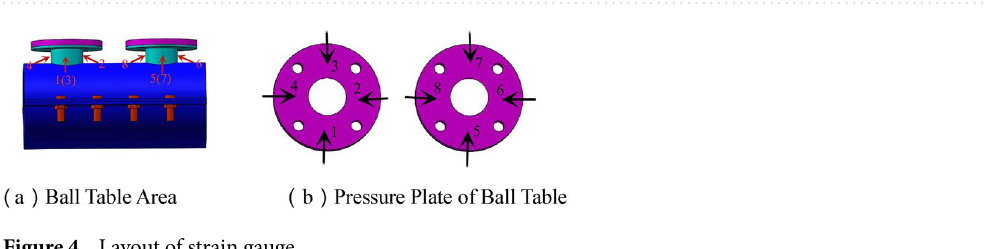
Figure 3. Layout of displacement gauge.